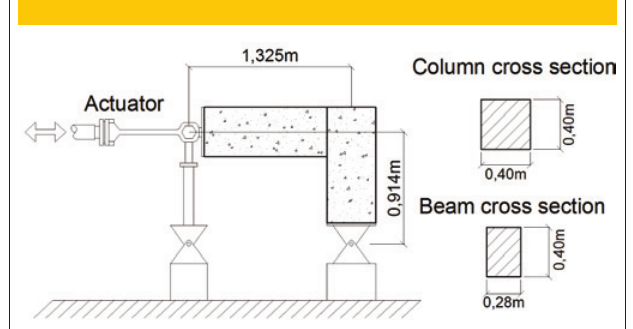
Table 2 – Comparison of actuator force with numerical results – T-Lateral exterior joint Model